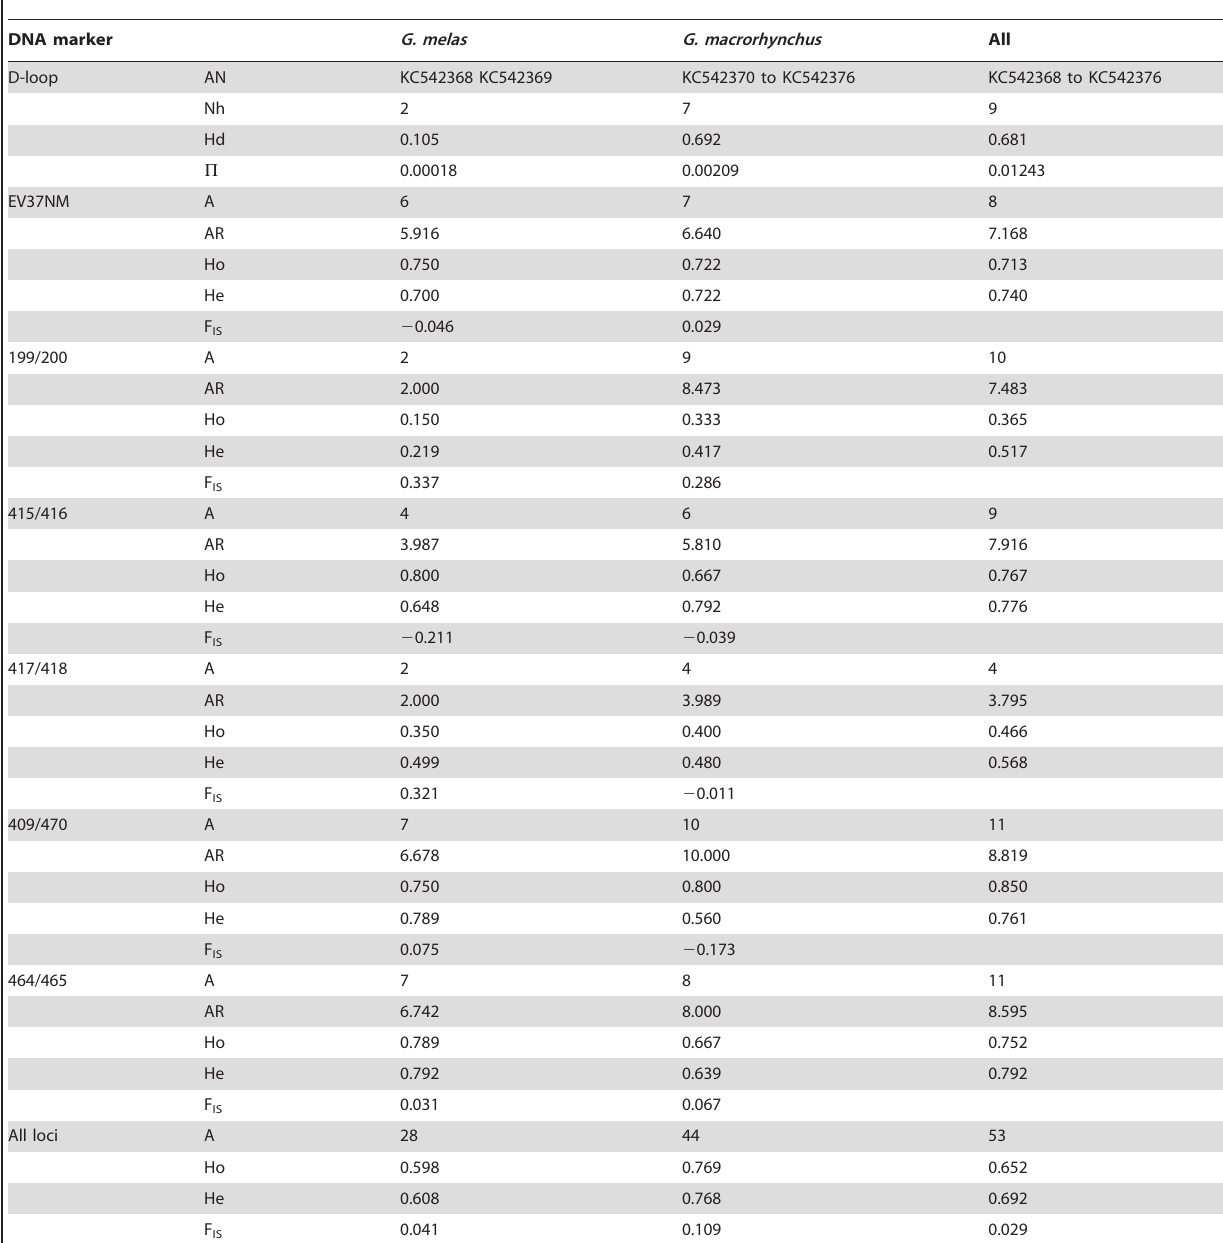
Table 2. Mitochondrial and nuclear variability of reference samples.